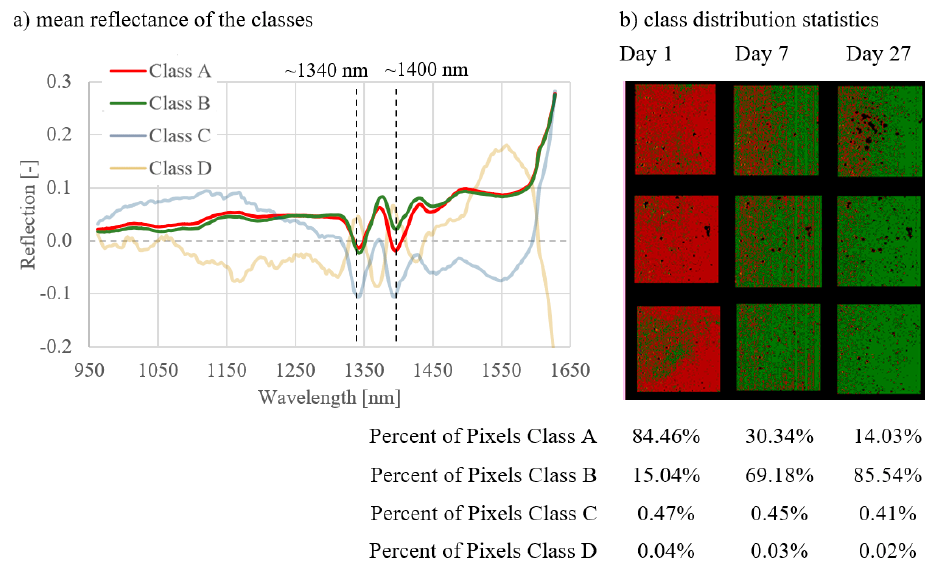
Figure 10. Results for combination 6; comparison of the measurement days of NB3 samples.